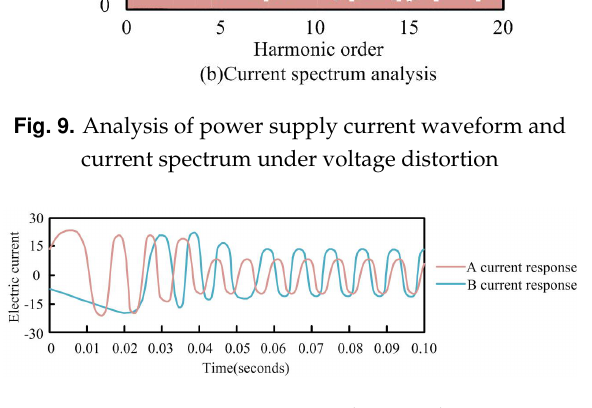
Fig. 10. Current corresponding conditions ter algorithm, using a second-order low-pass filter with a frequency of 50